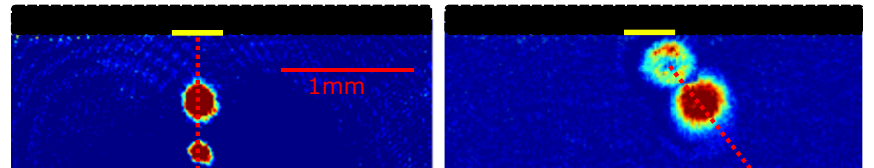
Figure 6: Absorption composite images in the longitudinal direction to illustrate the difference between current- and field- magnetization: The trajectory of the atoms to- wards the trapping wire for increasing bias field are illustrated for the case of a purely (Left) current-induced magnetization and (Right) field-induced remanent magneti- zation. The latter is a pure remanent trap without any transport current similar to [ 24, 26 ] where H is intentionally exceeded. The red dashed line illustrates the c 1 direction of the atoms for increasing bias field which leads to the superconducting trapping wire. The atomchip surface is indicated by the black region where the esti- mated location of niobium wire cross-section is illustrated in yellow. The composite images are for a bias field of 10 G (1.00 mT) and 30 G (3.00 mT), respectively. increases (See figure 6 left). The trap simply moves normal along the center line of the film just as in any conventional atomchip experiment. Field-induced remanent magnetization traps have an asymmetric current distribution, which means that the trap moves along an angle with respect to the normal vector at the center of the film wire width [ 22,24 ] . This is illustrated in figure 6 right for a pure field-induced remanent magnetization trap. Any significant